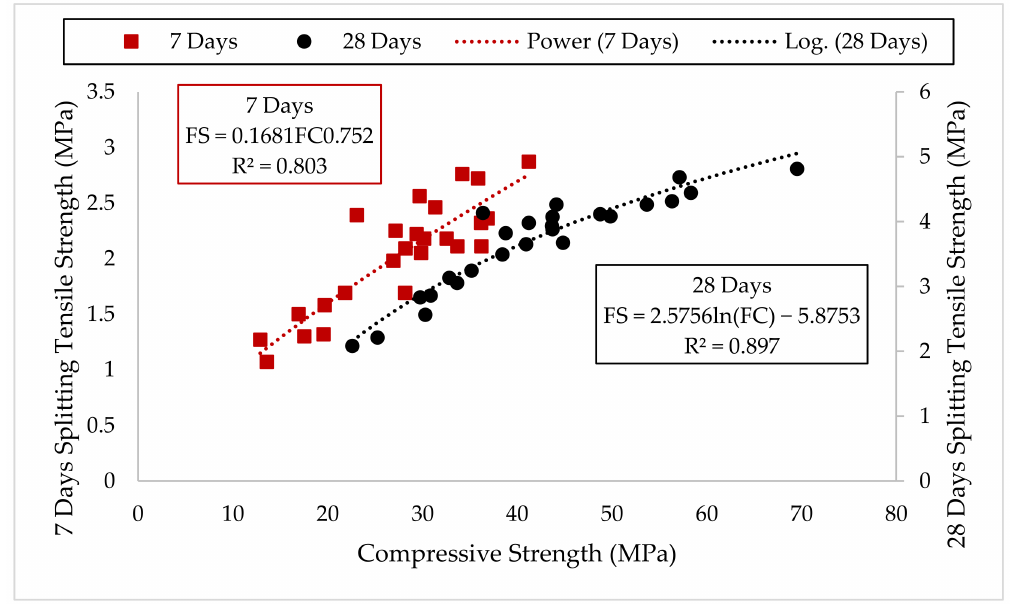
Figure 9. Relationship between splitting tensile strength and compressive